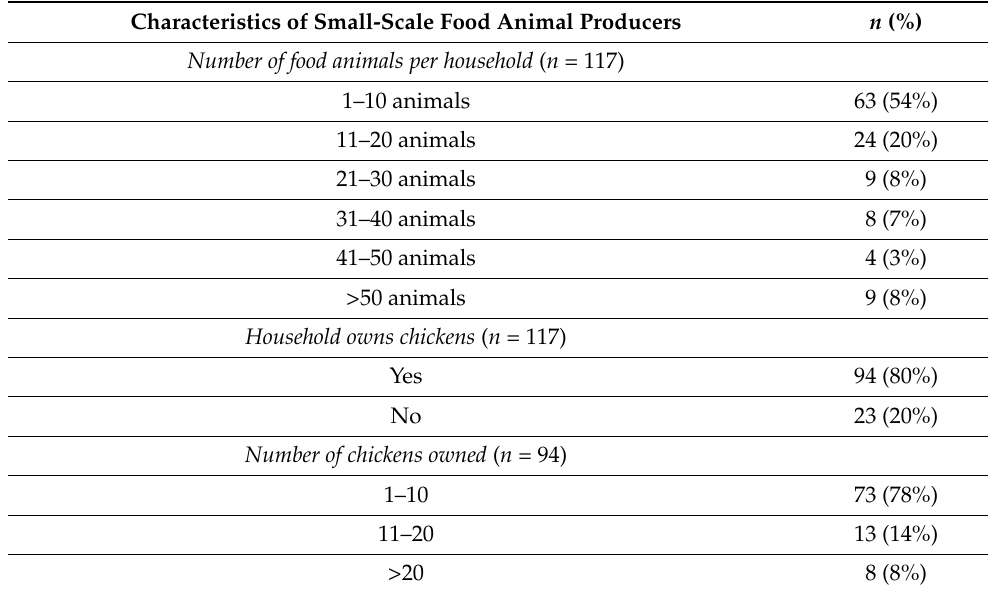
Table 1. Survey results among study households that owned small-scale food animals. Characteristics of Small-Scale Food Animal